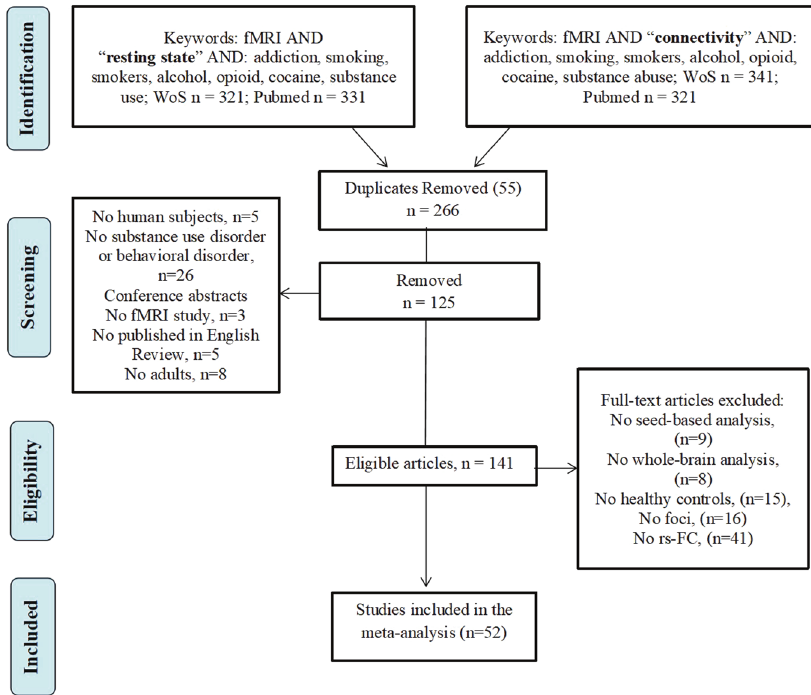
Fig. 1 PRISMA fl owchart. PRISMA fl owchart for the selection of eligible